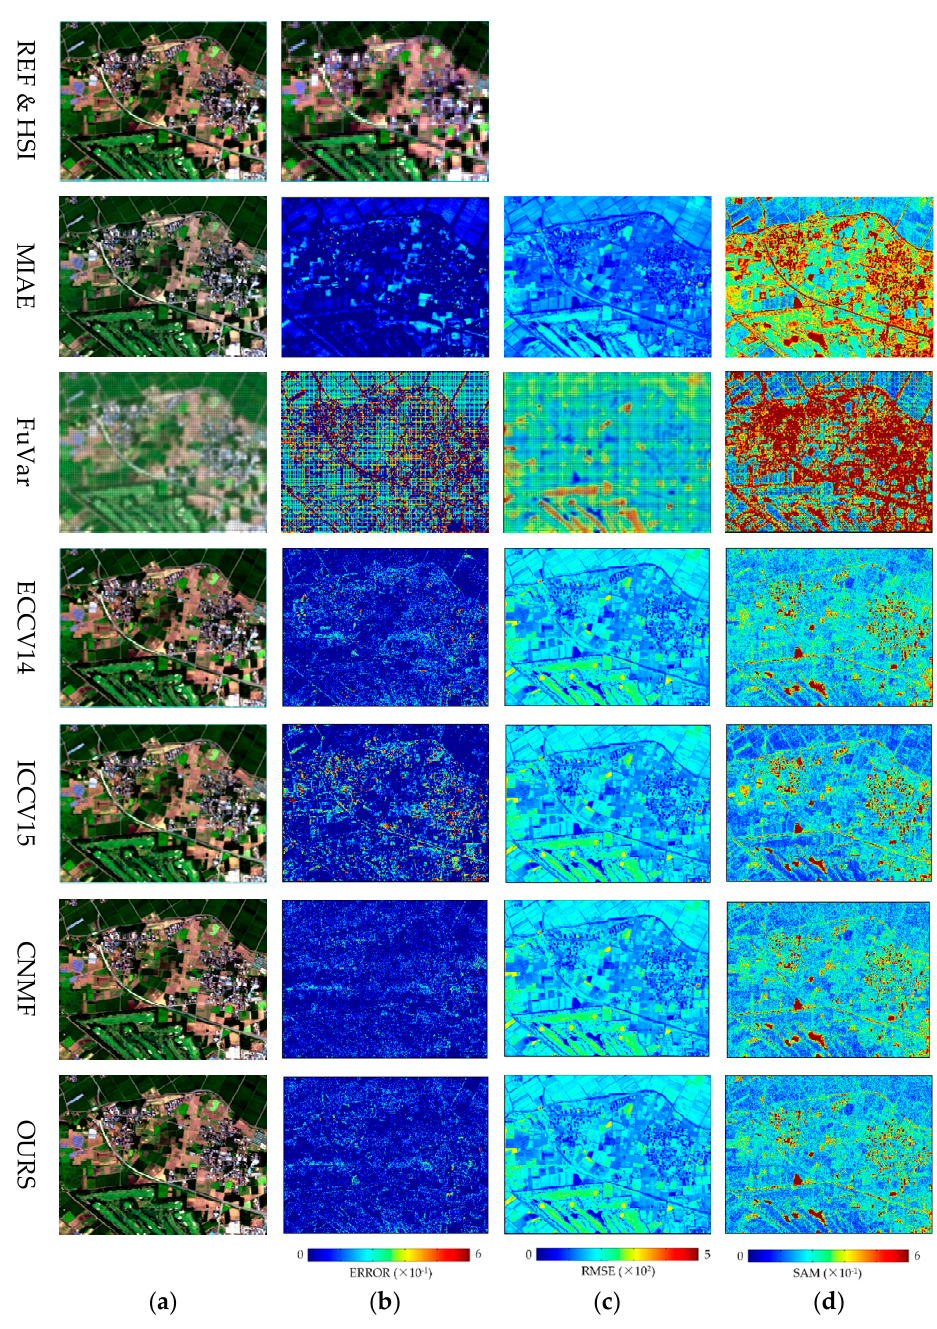
Figure 3. SRR results of Hyperspec Chikusei simulated data. (1st row) Color composite imageries of reference HSI and simulated LR-HSI. (2nd − 7th rows) Color composite imageries of the six meth- ods (( a ) column), color-composite error images relative to the reference data (( b ) column), RMSE (( c ) column), and SAM images (( d ) column).